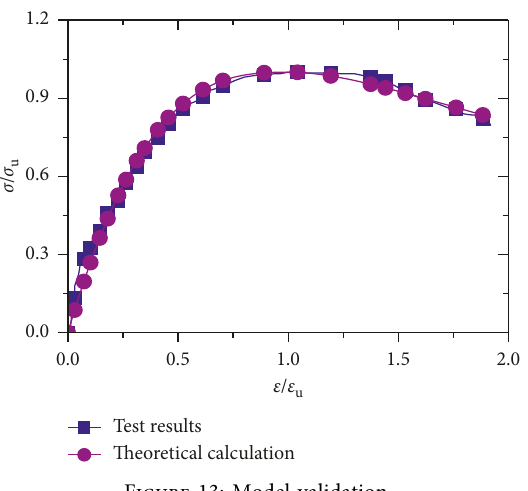
Figure 13: Model